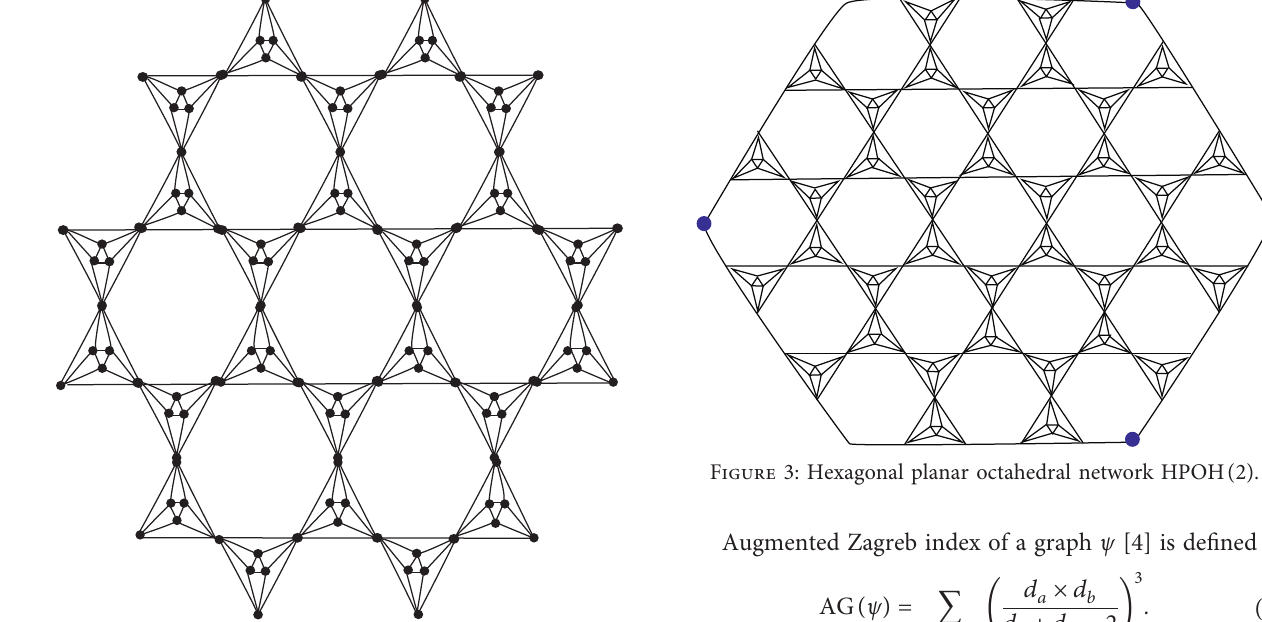
Figure 1: Planar octahedral network POH ( 2 ) .